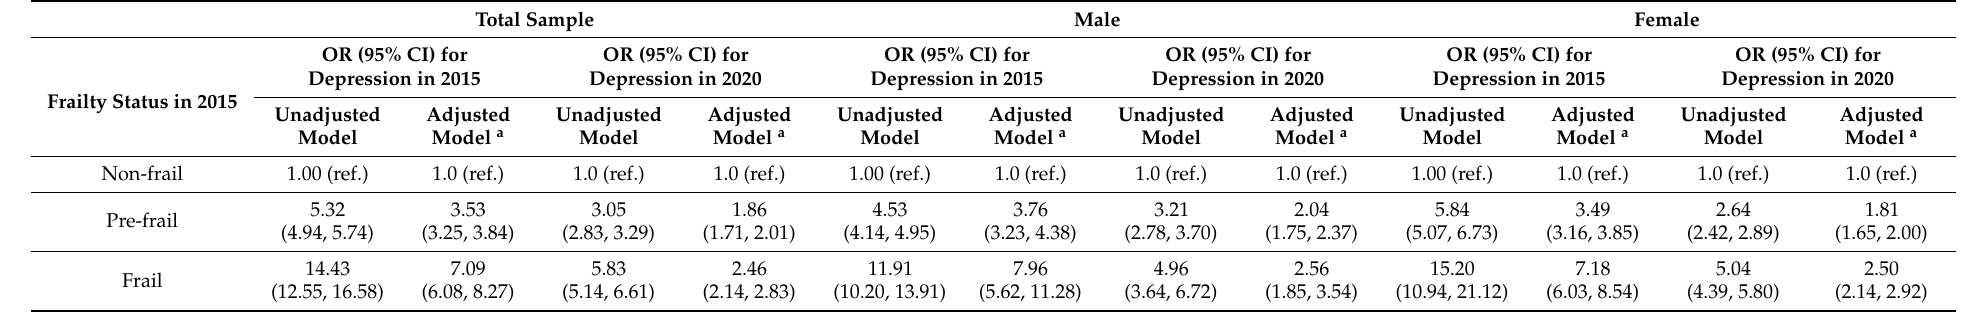
Table 3. Associations between frailty and depressive symptoms using bivariate logistic regression for the total sample and by